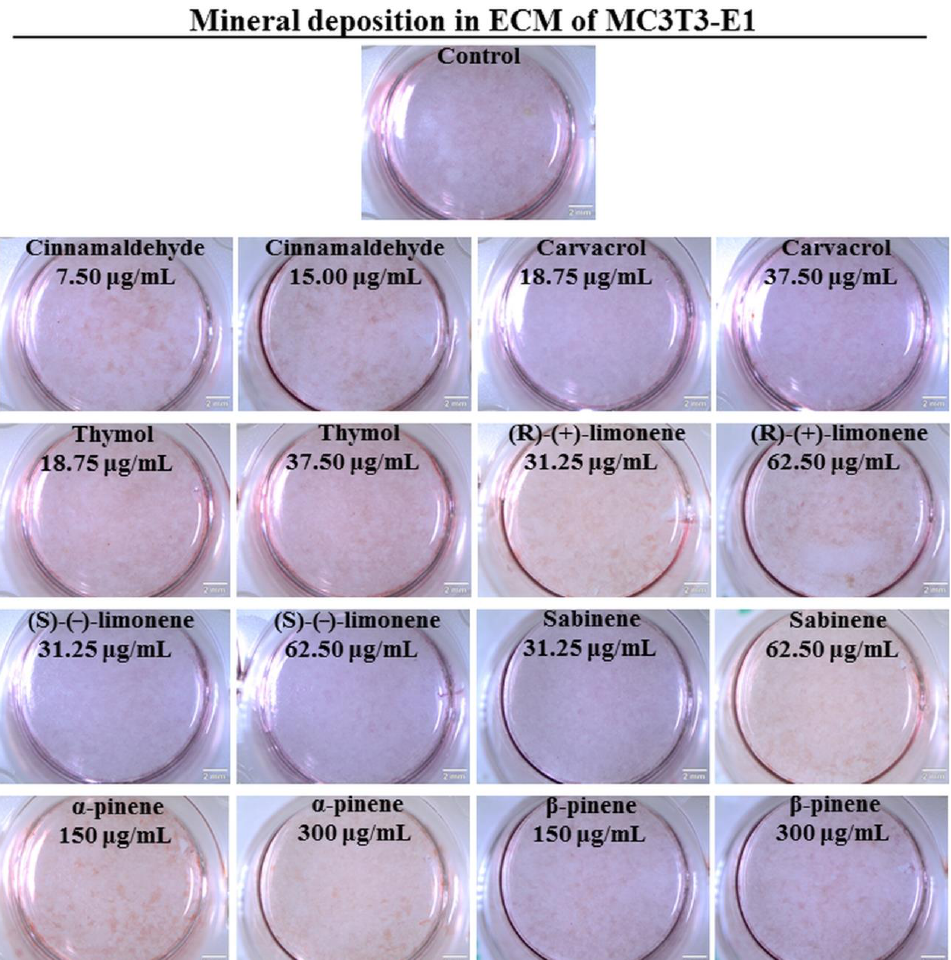
Figure 4. Qualitative evaluation of mineral deposition in the ECM of mouse primary calvarial pre- osteoblasts (MC3T3-E1 Subclone 4) assessed by Alizarin Red S staining and followed by stereoscopic microscope visualization (scale bar = 2 mm).